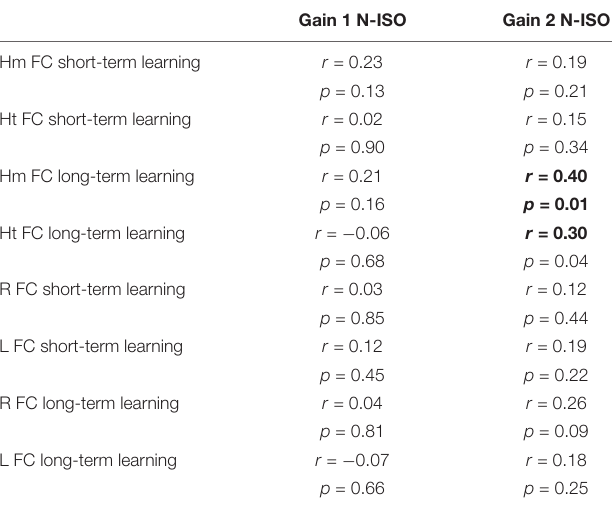
TABLE 2 | Correlations between inter- and intra-hemispheric rs-FC changes and BTT gains.